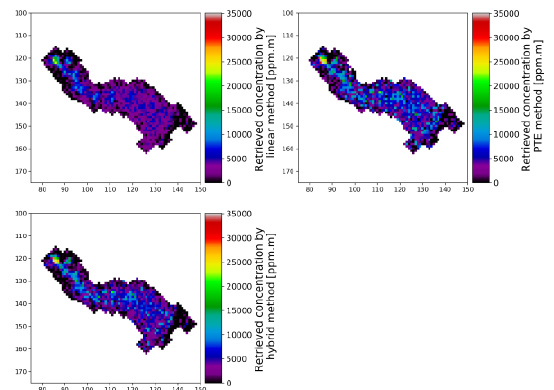
Figure 12 . Retrieved concentration map in ppm.m for the linear method (upper left panel), for the PTE method (upper right panel) and for the hybrid method (lower panel)